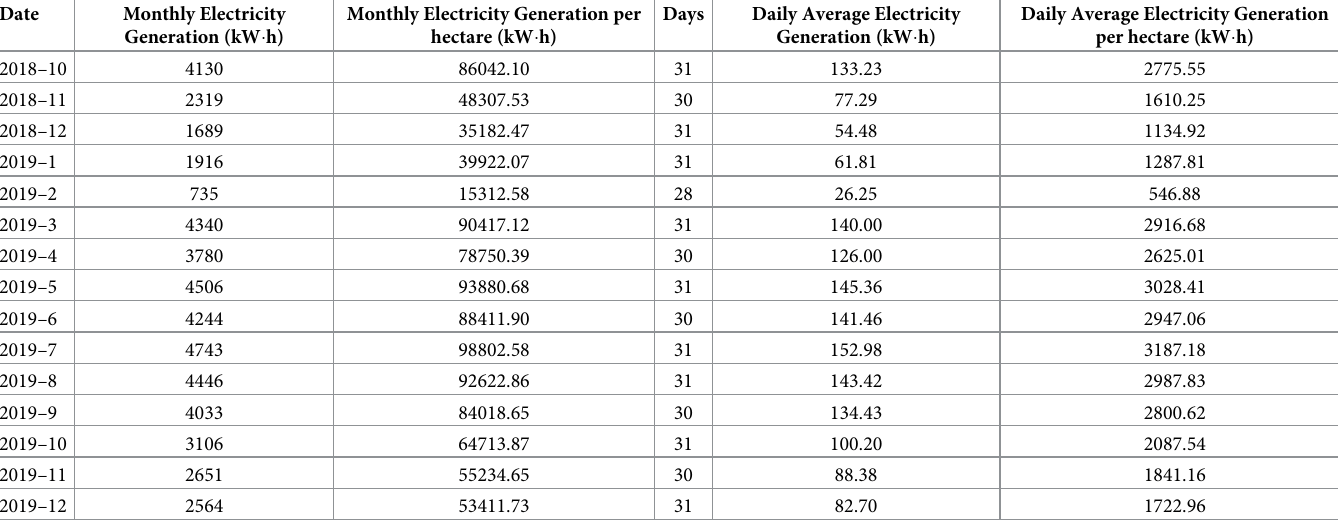
Table 6. Monthly electricity generation of the